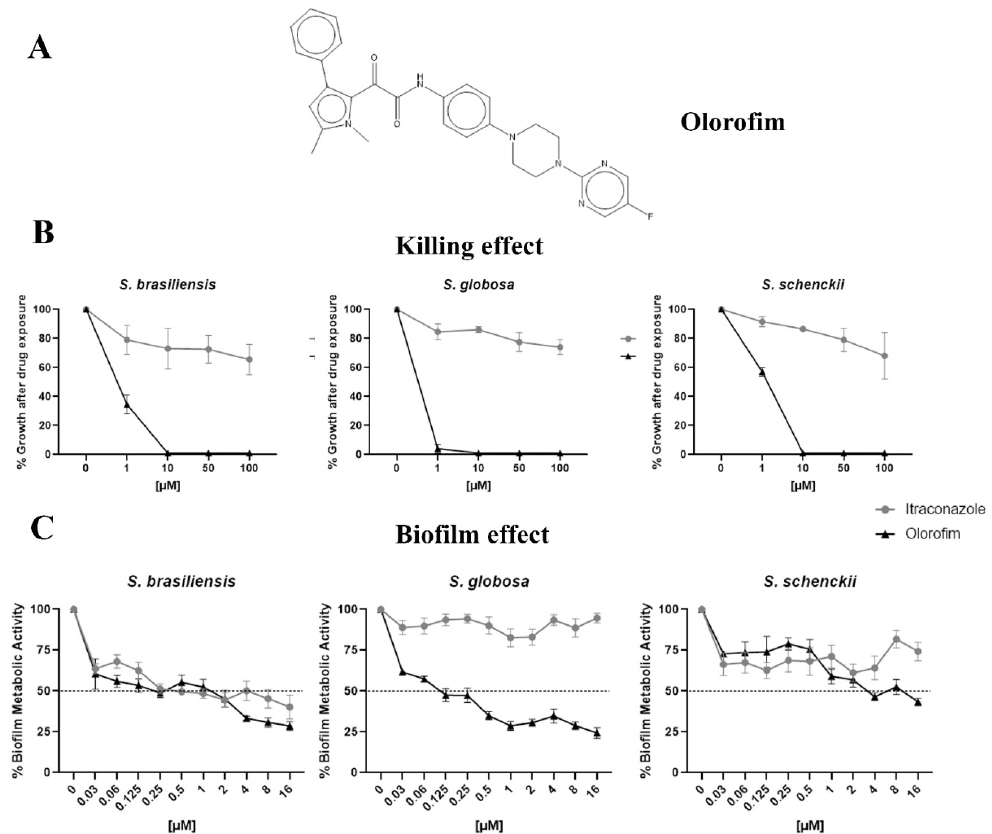
Figure 2. The anti- Sporothrix activity of olorofim. The chemical structure of olorofim ( A ). After exposure to olorofim or itraconazole, the yeast killing was evaluated by cultivation in a drug-free medium ( B ). The ability of olorofim to inhibit mature biofilms was determined according to the metabolic activity of cells in the presence of compounds ( C ). Results are shown as the mean of percent growth or metabolic activity and the standard error of the mean.